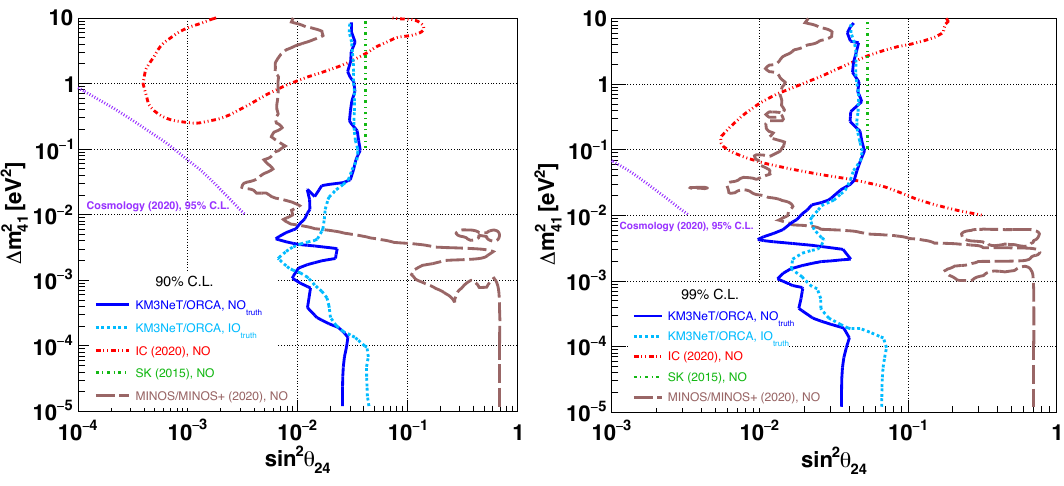
Figure 8 . The 90% (left) and 99% C.L. (right) KM3NeT/ORCA sensitivity to the mixing param- eter θ 24 , assuming three years of data taking. The obtained sensitivity is compared with current upper limits from cosmology [13], MINOS/MINOS+ [44], IceCube (IC) [45] and SK [42]. The ex- cluded region is the one on the right of the lines, for IceCube at 90% C.L. it is the external region to the closed contour